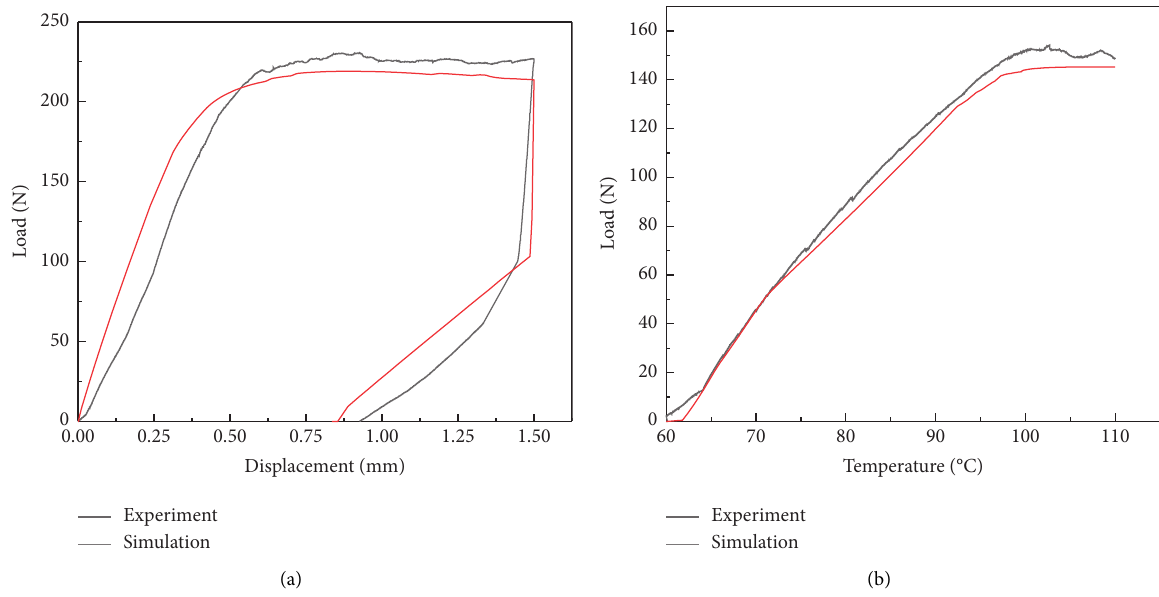
Figure 14: Experiment and simulation curves of small-pitch corrugated sample. (a) Compression-rebound curves of small-pitch corrugated sample. (b) Limited recovery load versus temperature curves for large-pitch corrugated